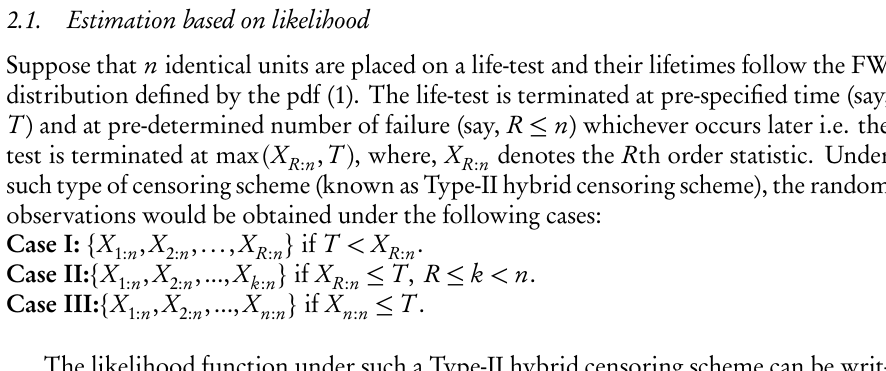
3. The predictive bounds of future samples are also constructed in respective section.